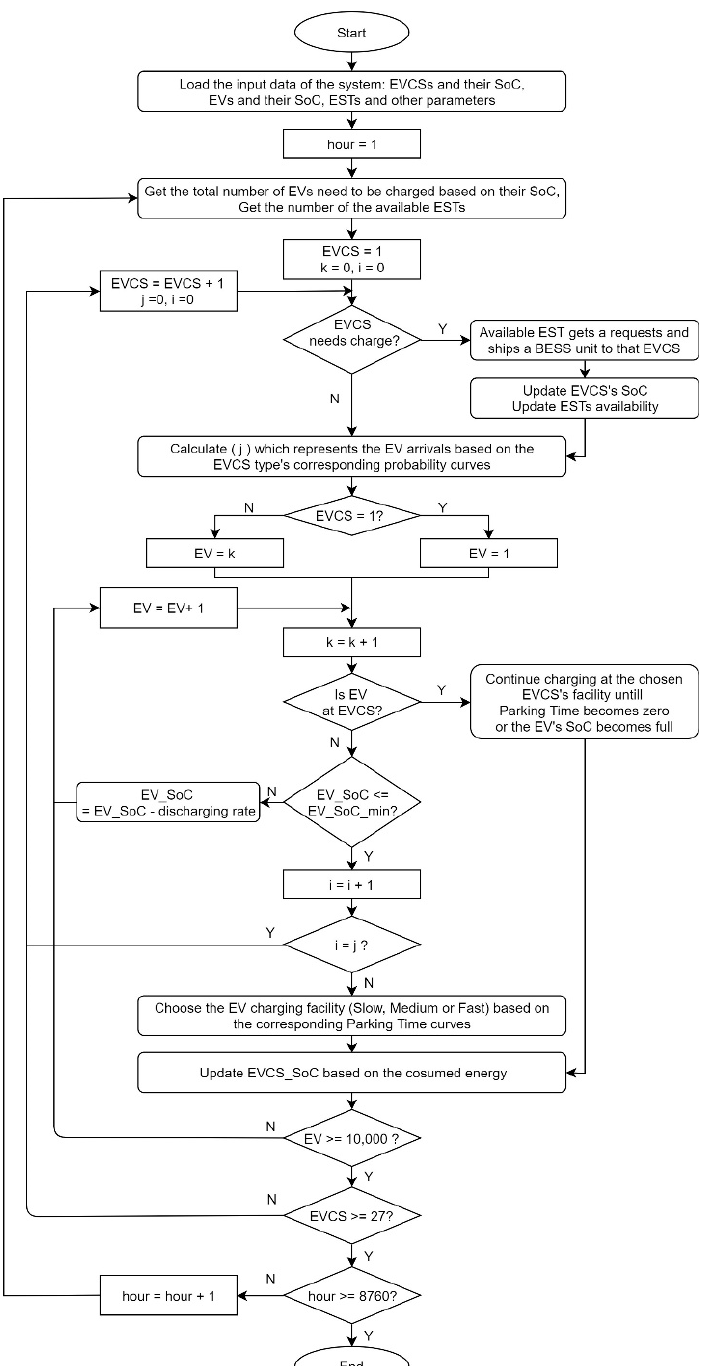
Figure 3. The flowchart of the simulation process.